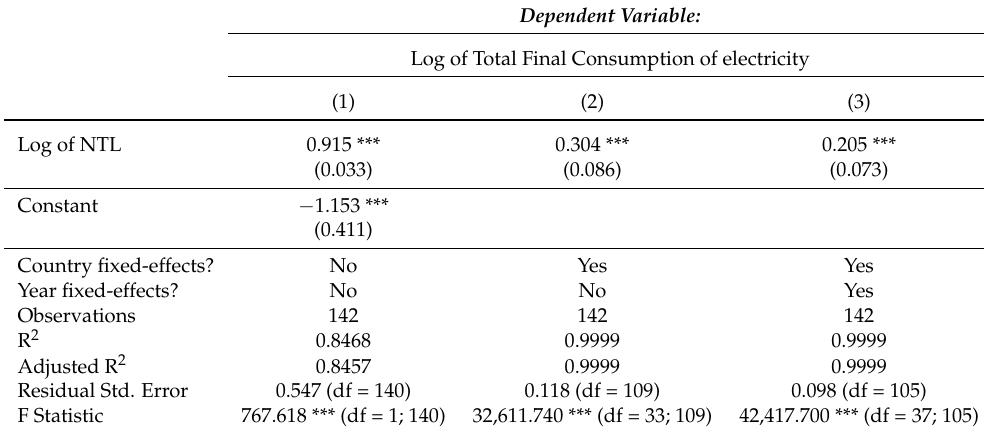
Table A7. Regression for RESIDENT—Lower-middle income countries.